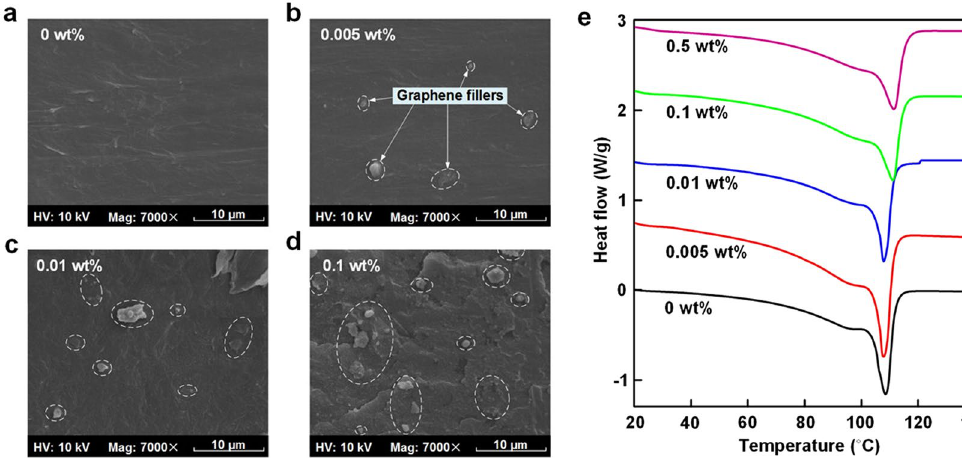
Figure 1. ( a , b , c and d ) are the SEM images of cross sections, corresponding to the 0 wt%, 0.005 wt%, 0.01 wt% and 0.1 wt% LDPE/graphene NCs respectively. ( e ) DSC curves of LDPE/graphene NCs as a function of filler